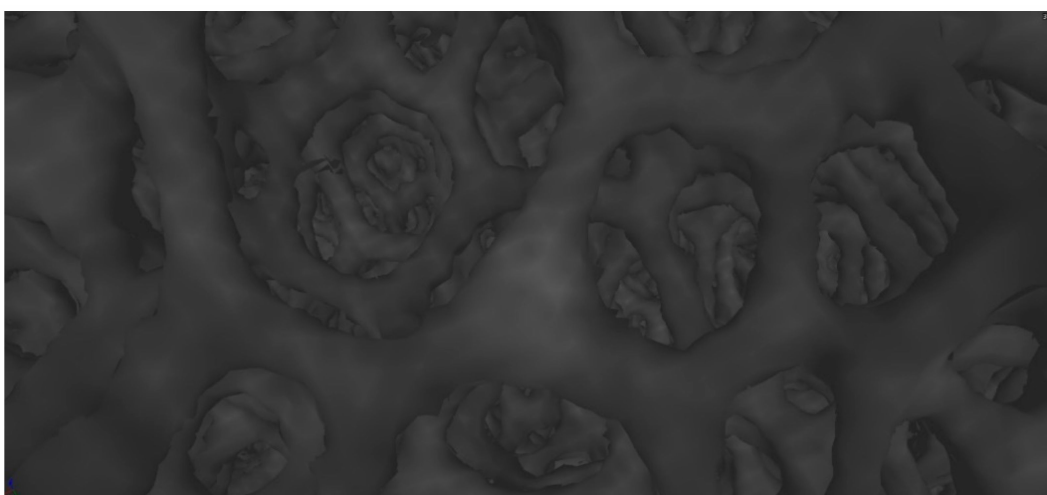
Figure 18. Open pore system of carbon sample visualized with a